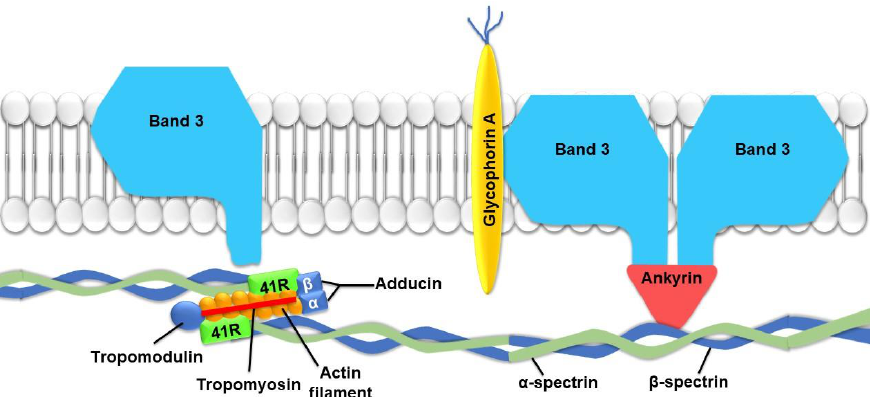
Figure 3. Schematic representation of important proteins involved in erythrocyte membrane flexibility. Spectrin molecules, responsible for stability and elasticity, are attached to the cell membrane by ankyrin. 41R protein establishes a link between actin and spectrin filaments. The essential deformability capacity of erythrocytes may be influenced by microen- vironmental (pH and osmolarity) and pathophysiological conditions (chronic hypergly- caemia and inflammation). Indeed, reduced erythrocyte deformability, in relation to mi-